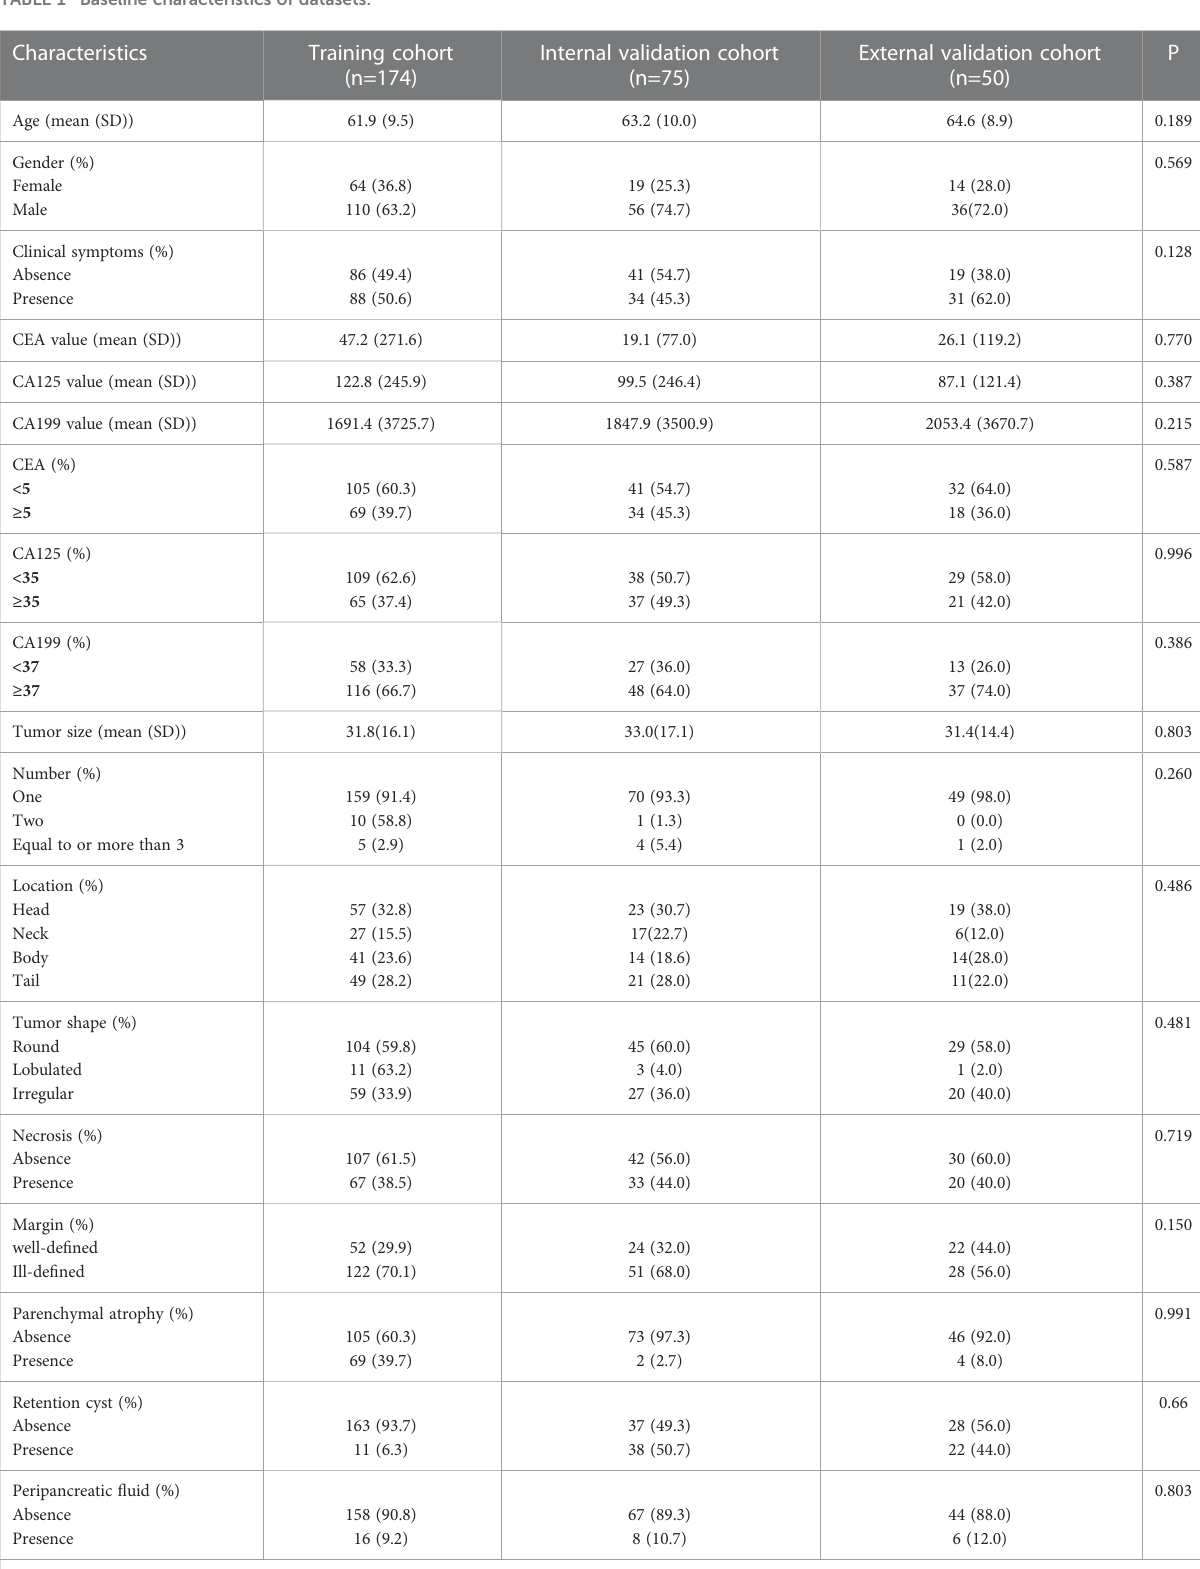
TABLE 1 Baseline characteristics of